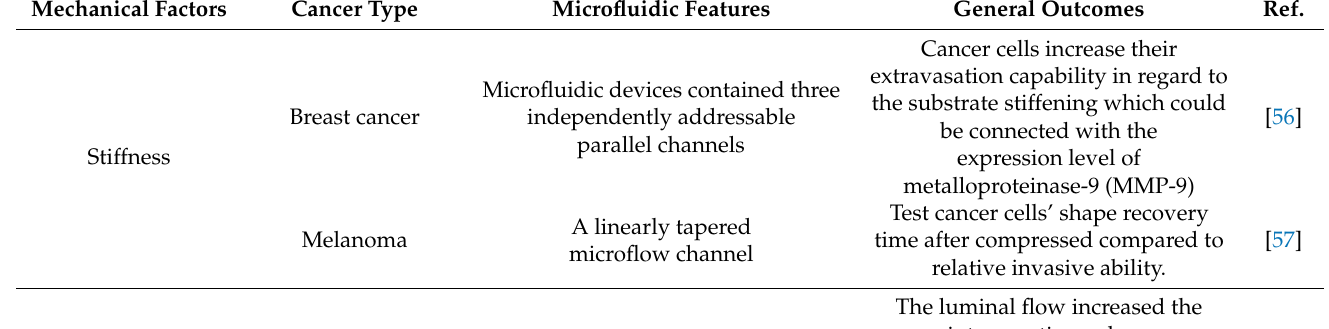
Table 2. Microfluidic modeling: A focus on mechanical factors in cancer cell